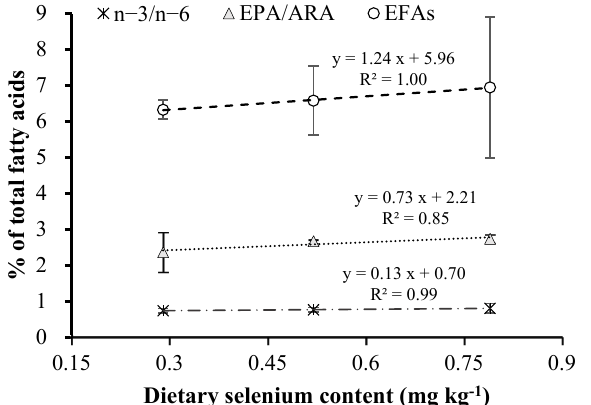
Figure 2. Relation between dietary Se levels and n ‐ 3/n ‐ 6, EPA/ARA and EFAs (essential fatty acids: DHA + EPA + ARA) in liver of gilthead seabream after 13 weeks of feeding diets with a different supplement of OH ‐ SeMet. Table 8. Fatty acid retention (% FA intake) in whole-body lipids of gilthead seabream after 13 weeks